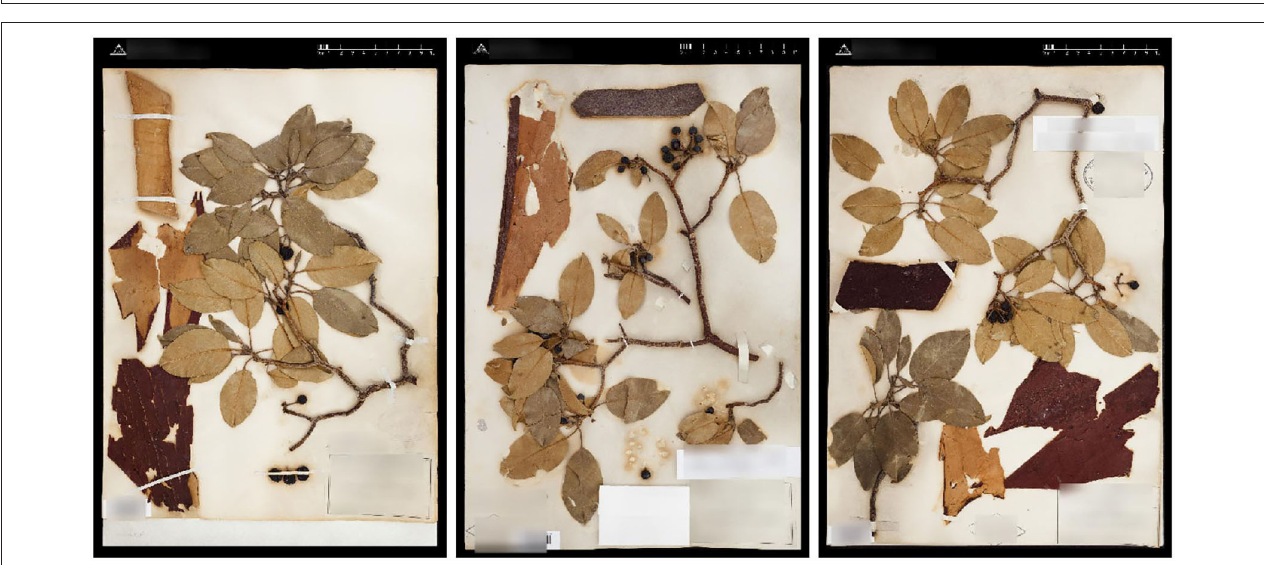
FIGURE 3 | Example of visually different images corresponding to the same species: Abarema brachystachya (DC.) Barneby and J. W. Grimes (Fabaceae). The observed differences are primarily due to different reproductive stages: early flowering, late flowering, and fruit.